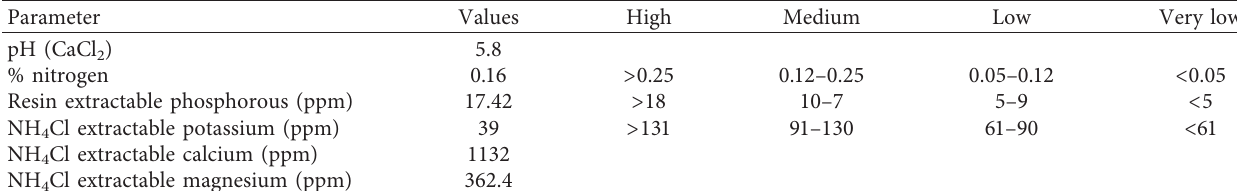
Table 1: Soil properties at scientific industrial research and development centre, Harare location.